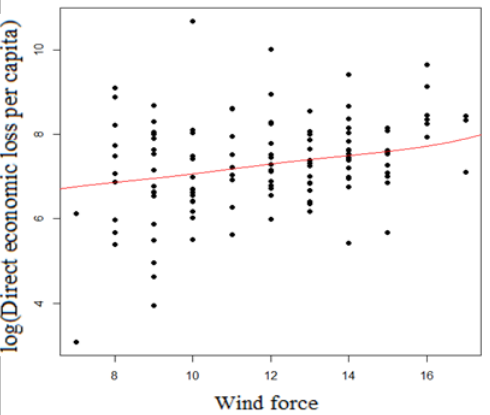
Figure 2. Scatter and non-parametric regression of direct economic loss with respect to wind forces.